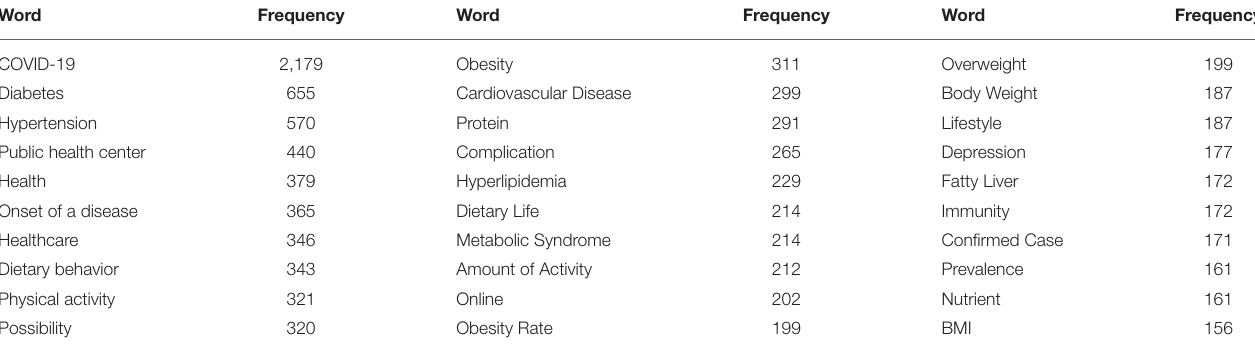
TABLE 5 | Top 30 frequencies after the COVID-19